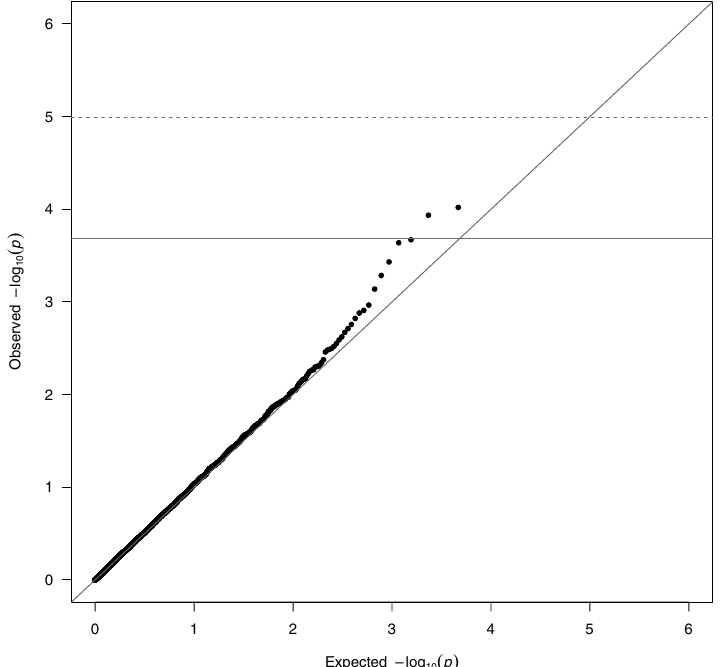
Figure 1. MiSTi results for Adaptive Weight test of predicted gene expression interactions with total folate intake. Dashed line is the Bonferroni corrected threshold, solid is the false discovery rate < 0.2 threshold for p-value significance.